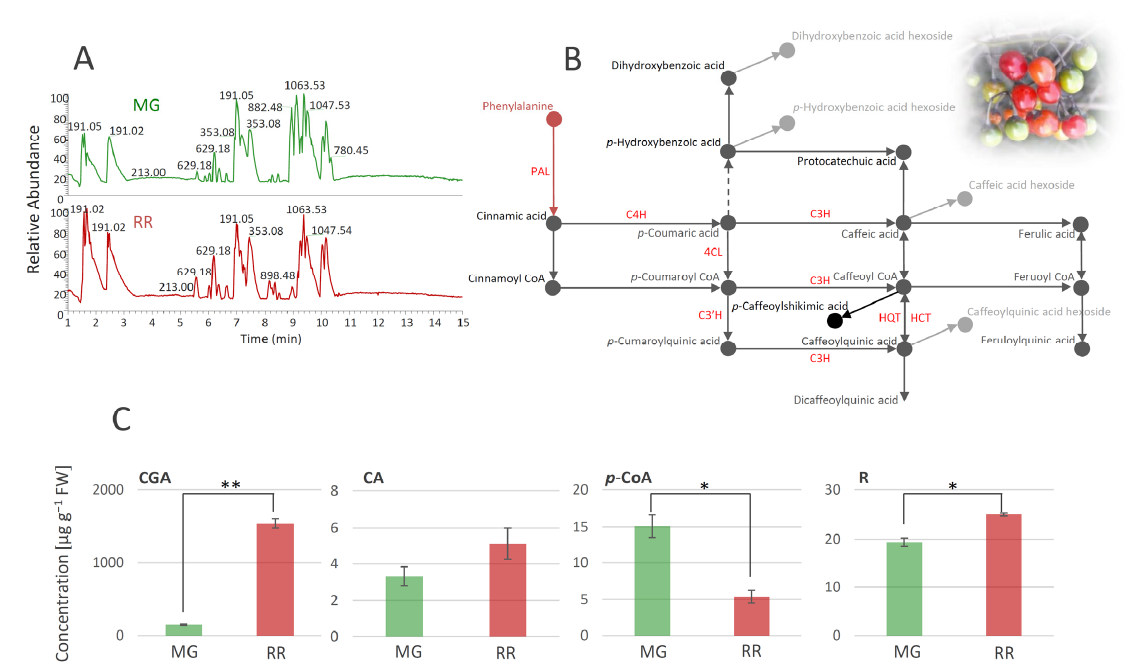
Figure 2. UHPLC/LTQ Orbitrap MS n chromatograms of methanol extracts of mature green (MG) and ripe red (RR) bittersweet fruits ( A ). Based on the qualitative profiles of polyphenolics, a putative biosynthetic route of major phenolic acids in bittersweet fruits is proposed ( B ), which is mainly represented by chlorogenic acid (caffeoylquinic acid), caffeic acid, and p -coumaric acid. UHPLC/( − )HESI-MS 2 quantitative analysis of major phenolic acids in MG and RR fruits ( C ): As- terisks (*) denote significant differences between MG and RR fruits according to the t -test, p